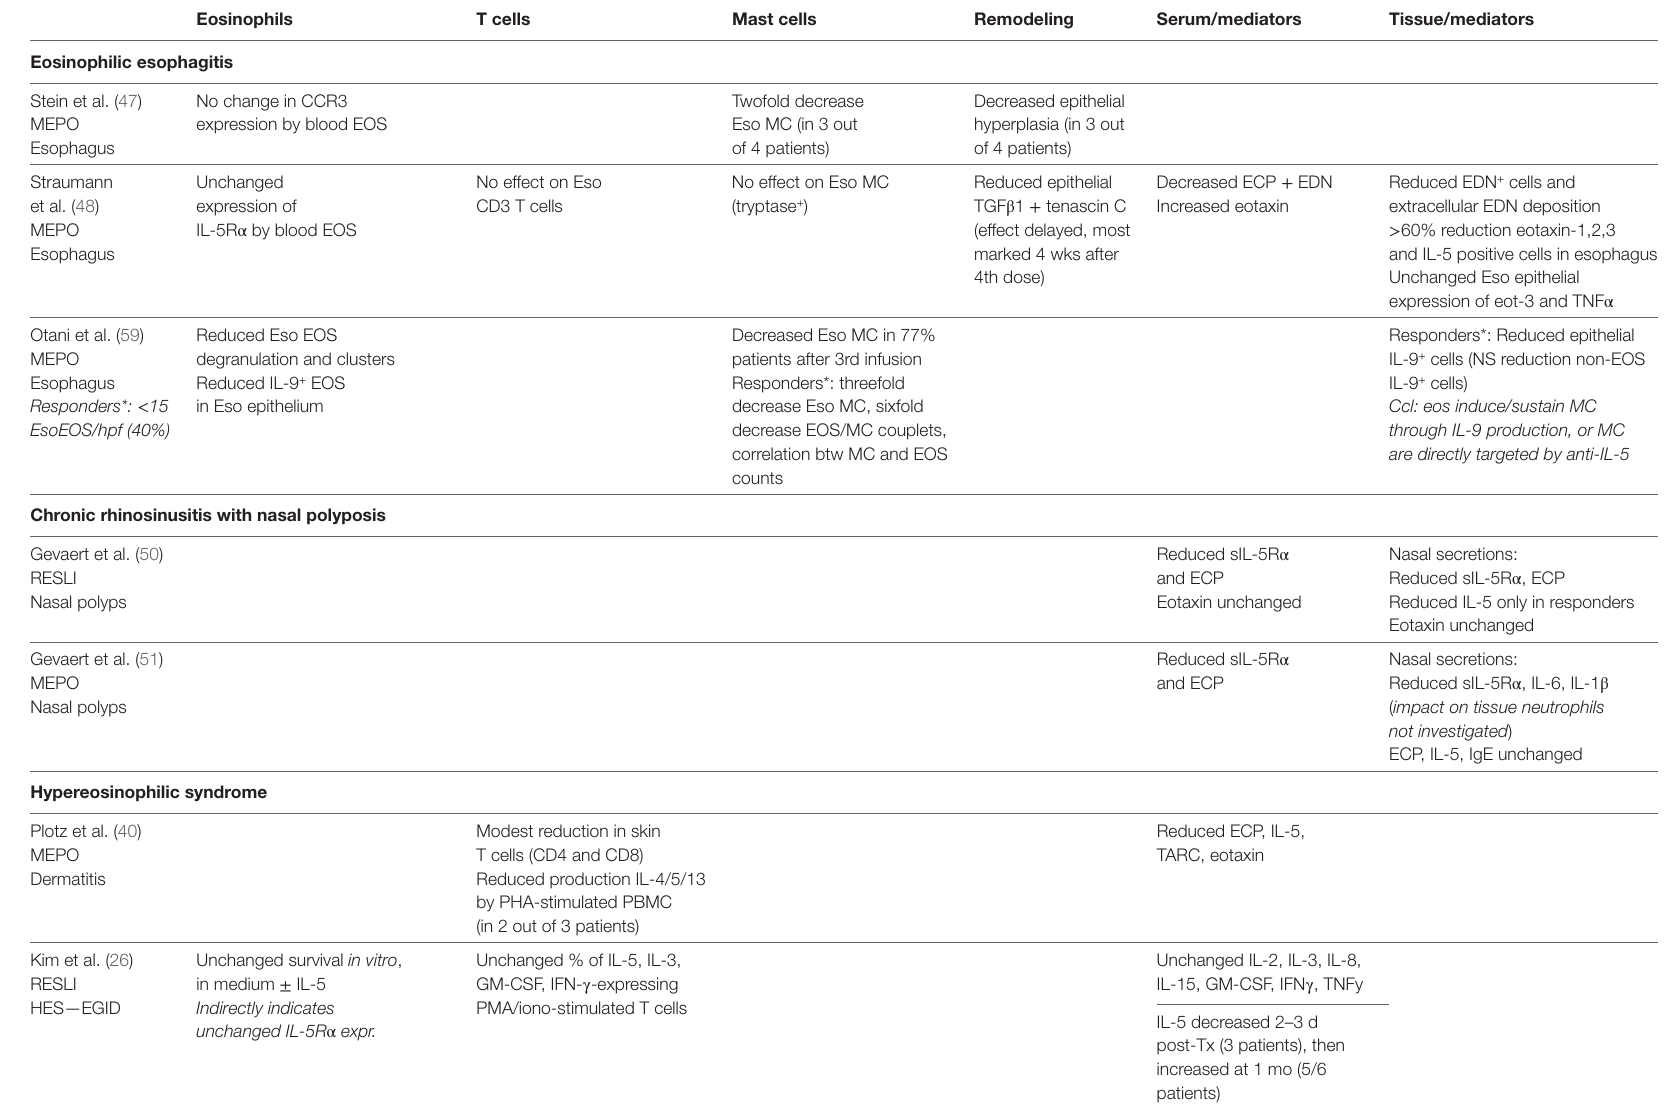
TABLe 4 | Biological effects of IL-5(R) targeted therapy other than eosinophil depletion in diseases other than asthma.